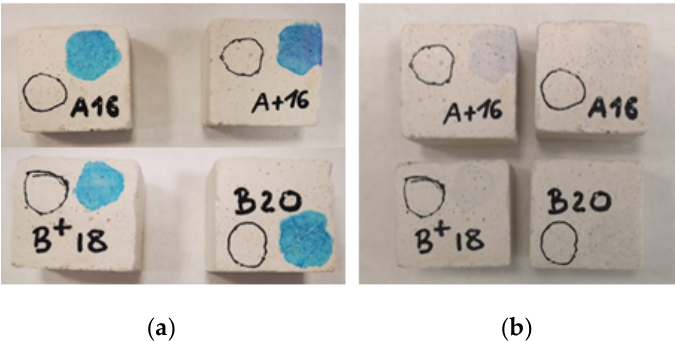
Figure 4. Methylene blue discoloration: samples ( a ) before and ( b ) after 1-week exposure to UV rays.